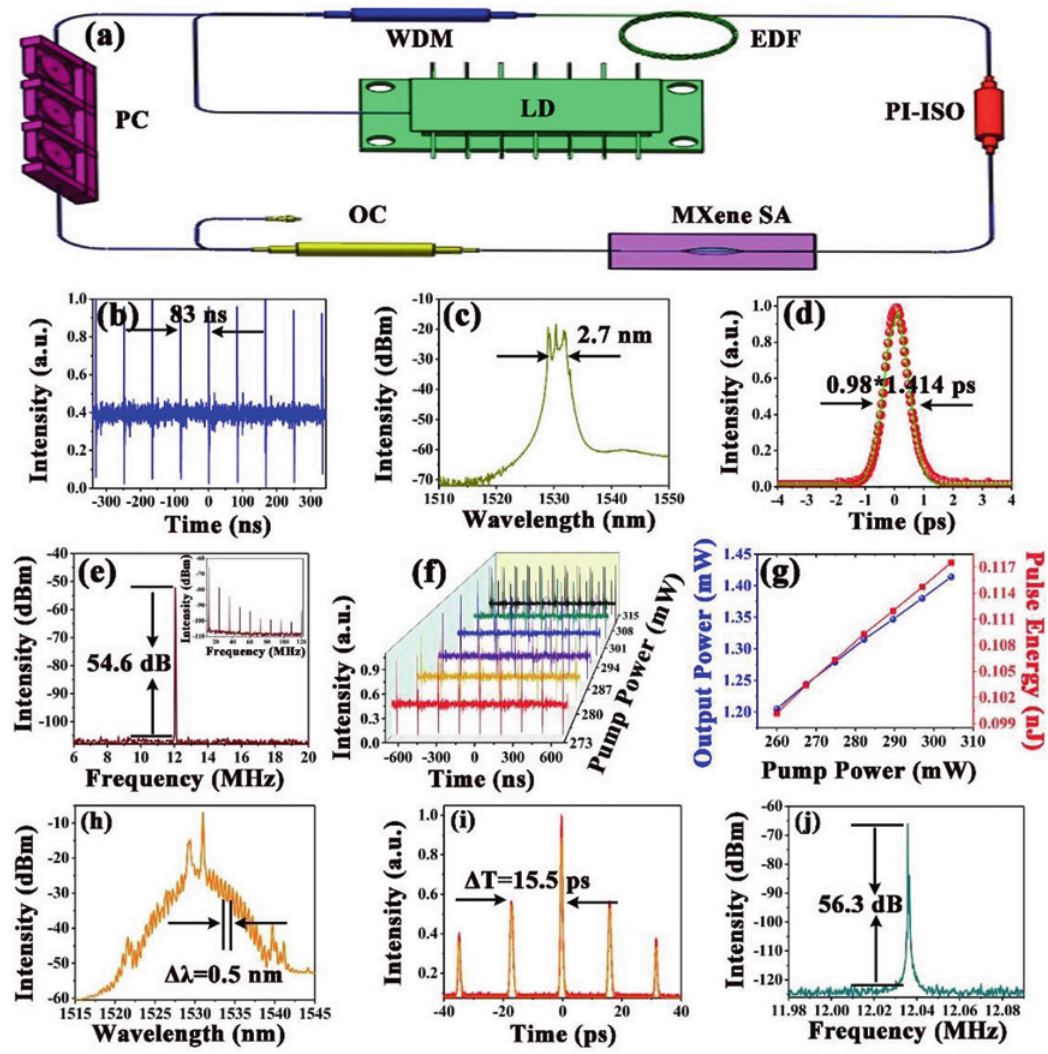
Figure3: (a)Schematicofmode-lockedfiberlaser.(b)Typicaloscilloscopepulsetrainsofmode-locking.(c)Mode-lockedopticalspectrum.(d) Autocorrelation trace with a gauss fitting (the red and green curves represent the experimental and fitting results respectively). (e) Frequency spectrumoftheoutputpulse.(f)Pulseevolution.(g)Outputpowerandpulseenergychangingresultswithpumppower.(h)spectrumofsoliton molecule pulse. (i) Autocorrelation curve of soliton molecule pulse. (j) Frequency spectrum of soliton molecule